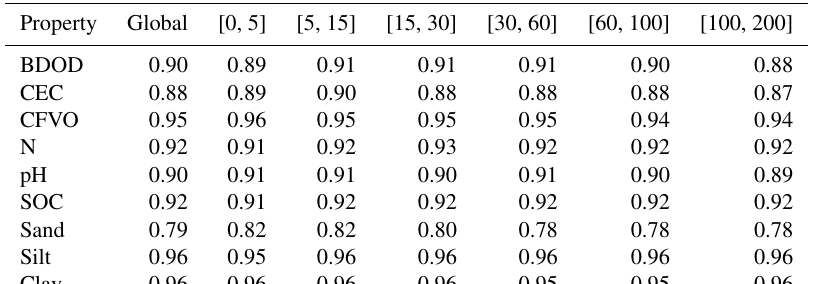
Table 6. Prediction interval coverage probability, global and by predicted depth interval. See Table 1 for abbreviations and units of the soil properties considered.